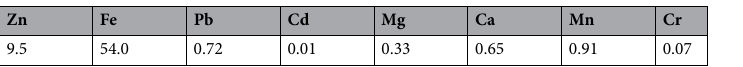
Table 1. Chemical composition of the steel-making sludge